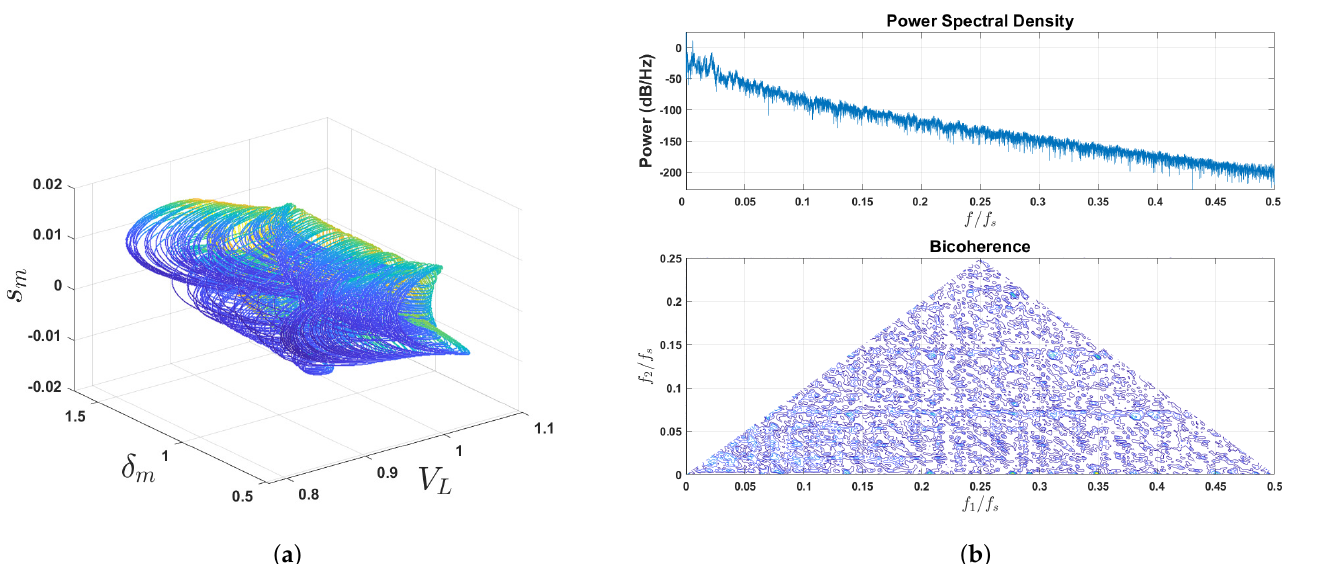
Figure 3. The chaotic power system (1) attractor and bicoherence plot. ( a ) Phase portrait strange attractor of the chaotic power system (1). ( b ) Power spectral density and bicoherence for the chaotic power system (1).